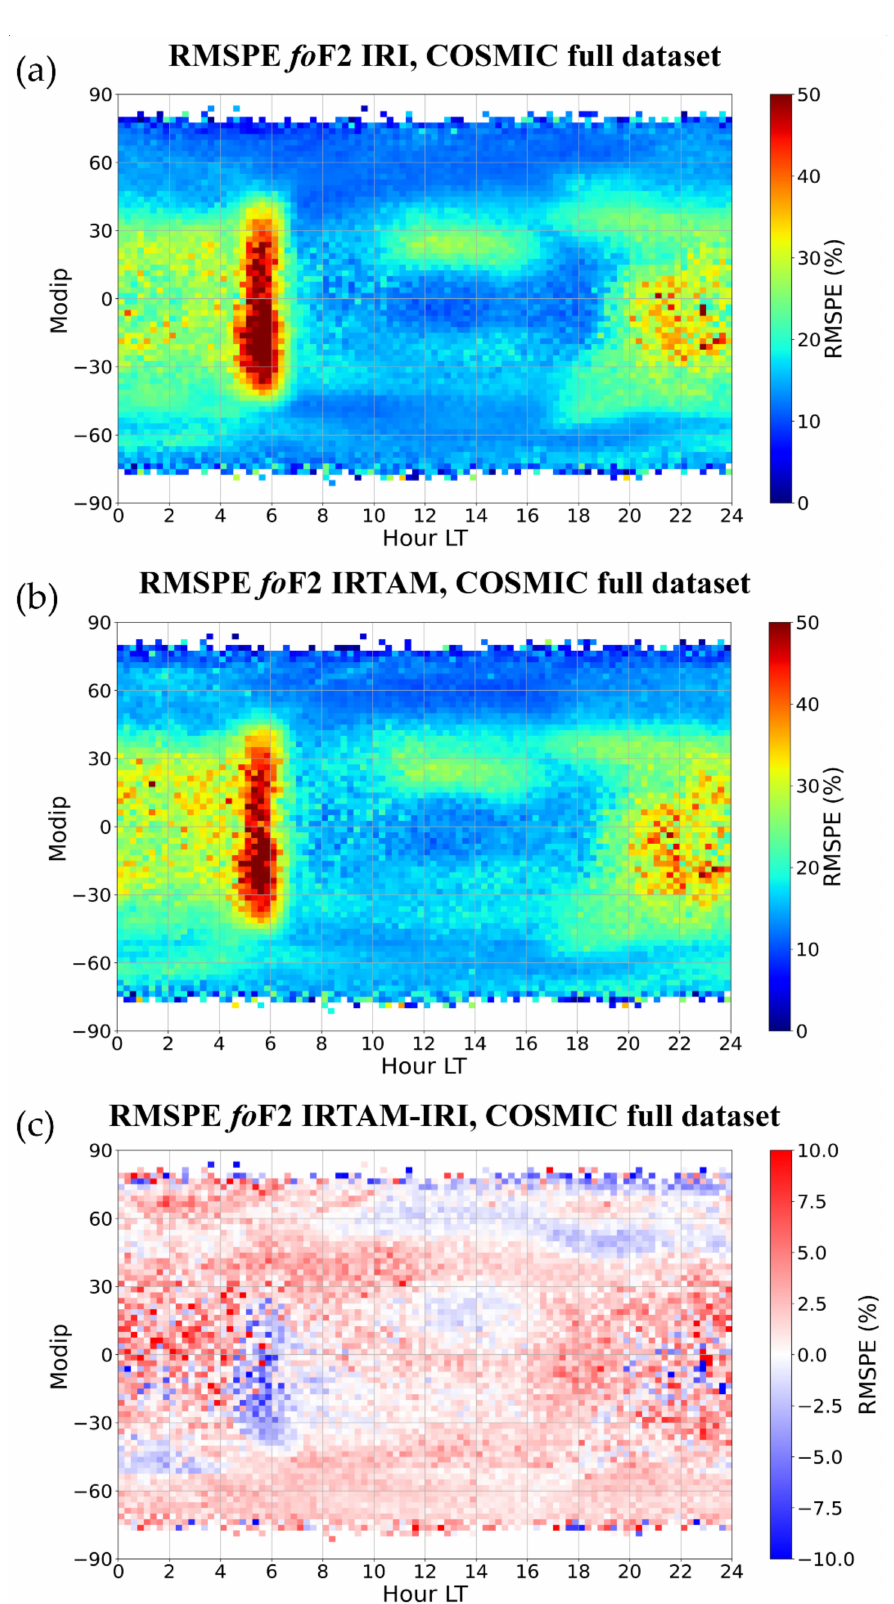
Figure 21. Grids of binned RMSPE values calculated between fo F2 measured by COSMIC satellites and modeled by ( a ) IRI and ( b ) IRTAM, and ( c ) the corresponding grid of differences. Data were binned as a function of the LT (fifteen minute-wide bins) and modip (2.5 ◦ -wide